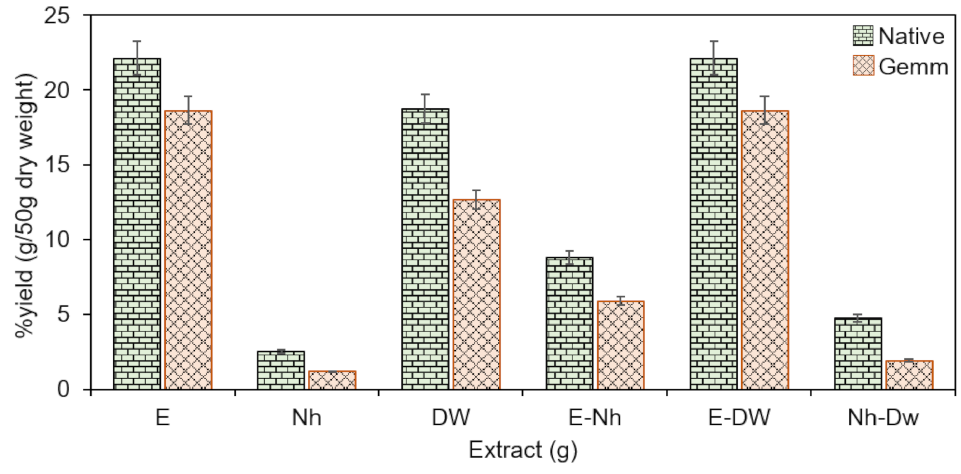
Figure 1. Percent (%) yield of both Native and gemm extracts of H. griffithi using mono and binary solvents (1:1) for extraction. E: ethanol, Nh: n -hexane, DW, distilled